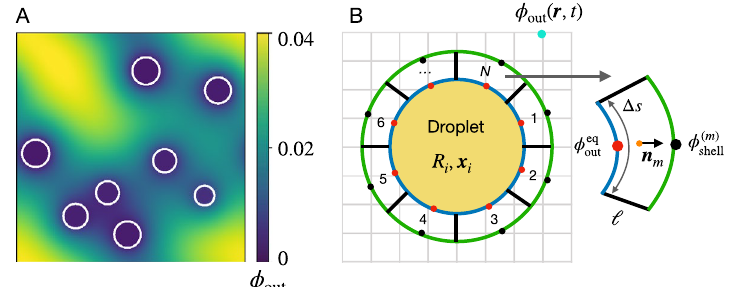
Figure 1. Schematics of the simulation model, describing droplets and the background field φ out . ( A ) Droplets co-exist with the background field φ out and interact with it only through material fluxes. For simplicity, φ out also exists at the location of the droplets, but this has negligible effect on the dynamics. ( B ) Isolated droplet (yellow) with a surrounding shell of thickness ℓ , which is further discretized in N sectors of linear size (cid:31) s . The exchange fluxes between droplet and background are determined in each sector based on the equilibrium fraction φ ( m ) (red dots) and the value φ out at the outer side (black dot), which is determined from the background field using bilinear interpolation. The background field φ out is uniformly discretized on a Cartesian grid (gray